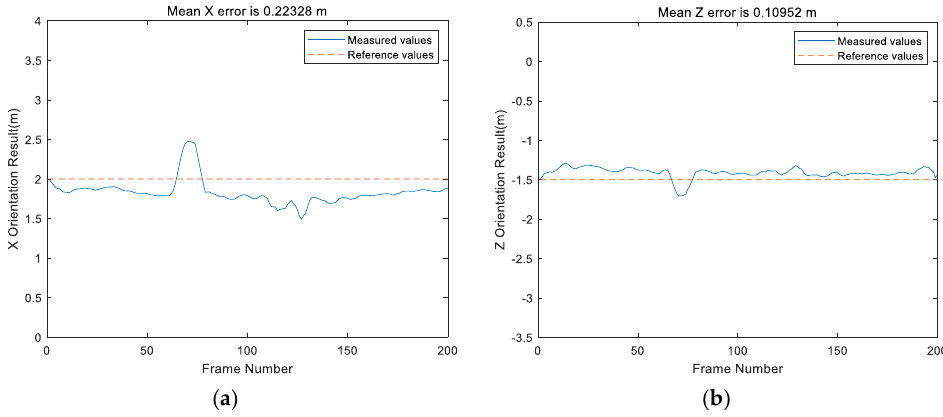
Figure 15. The SVD–STKF positioning results under the source rotation for the point (2, −1.5). ( a ) Error in the x–direction. ( b ) Error in the z–direction.